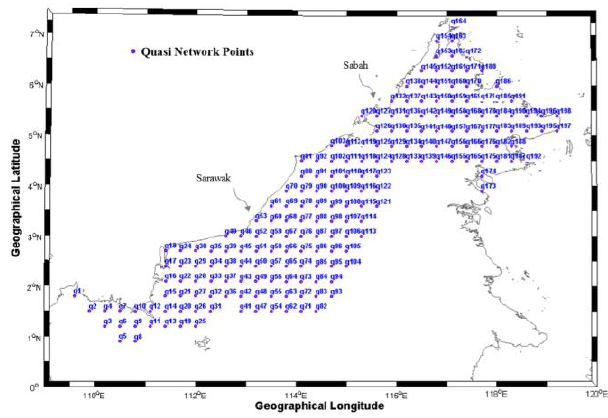
Figure 11. Quasi Network points in Peninsular Malaysia with 0.3°× 0.3° (~15km2) spatial resolution from (Q1 – Q144). In Sabah and Sarawak region, Quasi Network prediction with 0.3°×0.3° grid were performed within the inland area bounded within 0.5°N-7.5°N and 109°E-119.5°E as illustrated in Figure 11. From the figure, 197 Quasi Network points were generated to cover the inland region of Sabah and Sarawak (from q1 until q197 situated in the west and eastern part of the region, respectively).